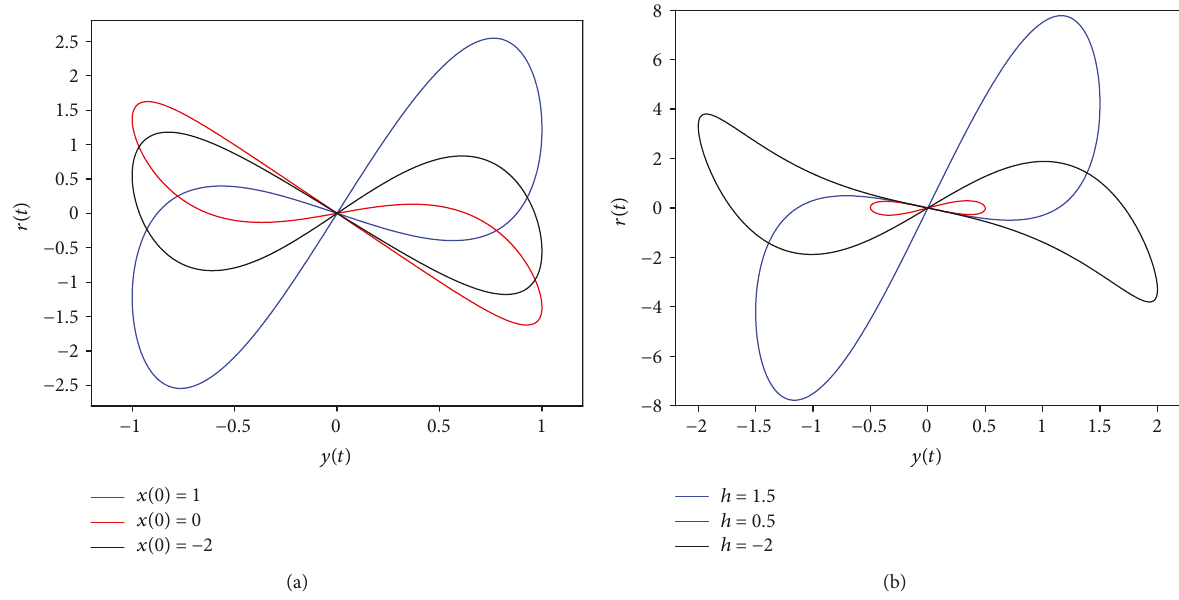
Figure 2: Relationship curves of input and output under (a) di ff erent initial states and (b) di ff erent amplitudes of the sinusoidal